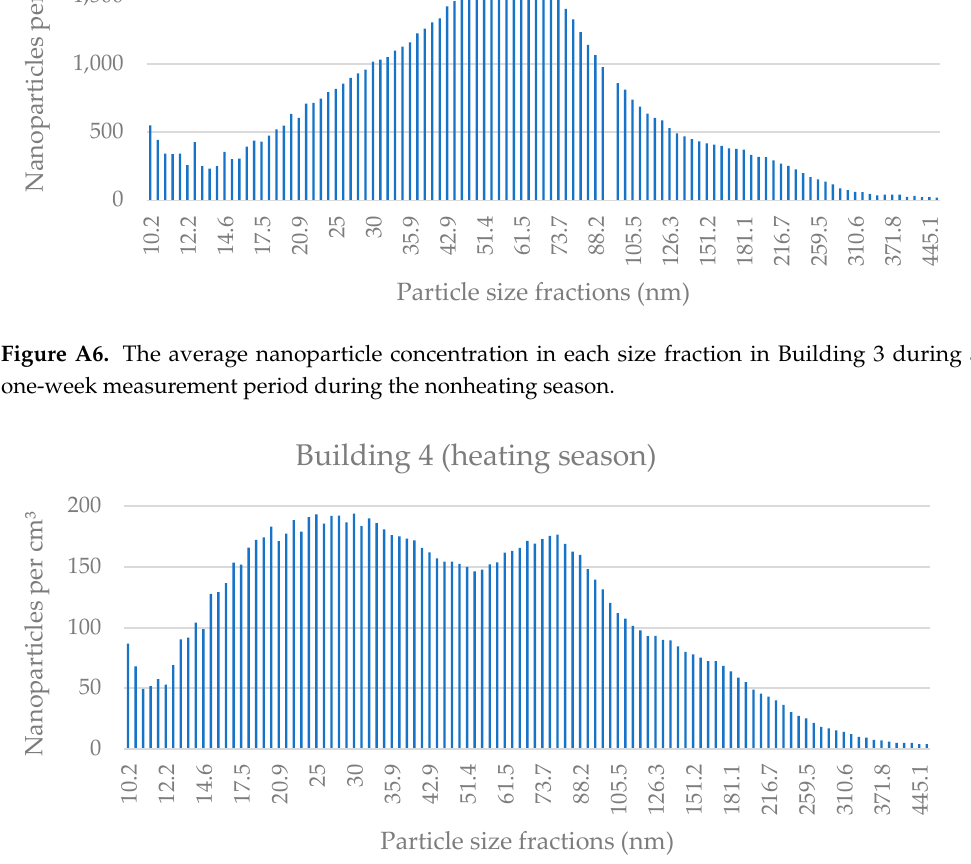
Figure A7. The average nanoparticle concentration in each size fraction in Building 4 during a one-week measurement period during the heating season.